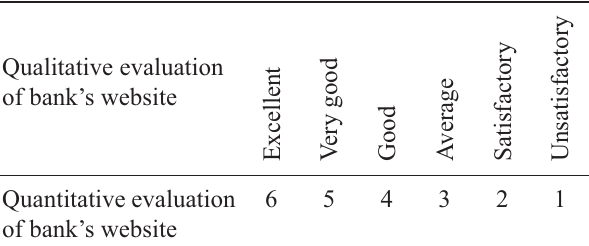
Table 2. Quantitative evaluation of the